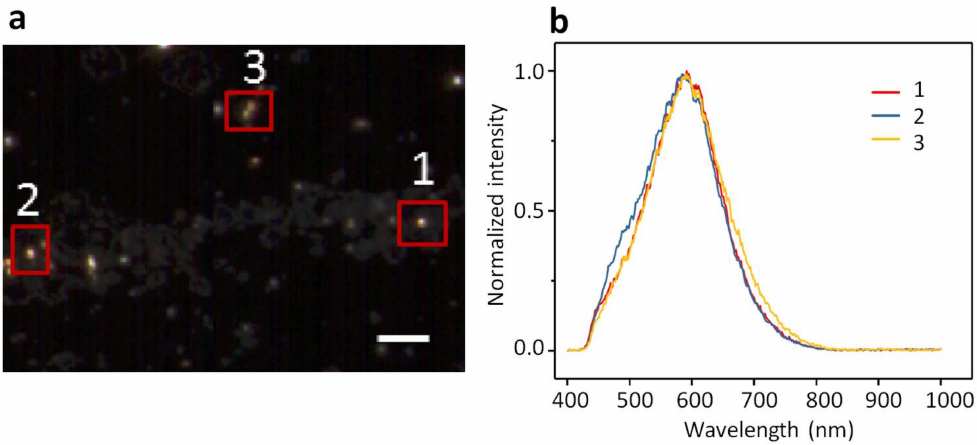
Figure 1. ( a ) A dark-field microscopy (DFM) image of 10-nm AuNPs dispersed in PBS buffer and ( b ) the normalized spectral profiles collected from three different particles specified in ( a ). The three spectral profiles in ( b ) peak are around 590 nm. Scale bar is 5 µ m.